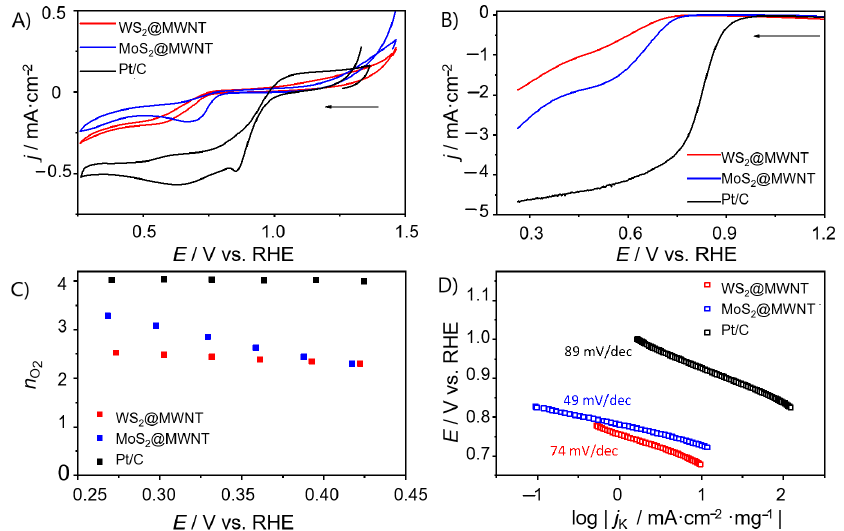
Figure 3. Electrochemical studies on WS2@MWNT, MoS2@MWNT and Pt/C. ( A ) Cyclic voltammograms (CVs) (O 2 -saturated 0.1 mol · dm − 3 KOH, v = 0.005 V · s − 1 ), ( B ) Linear sweep voltammograms (LSVs) at 1600 rpm (O 2 -saturated 0.1 mol · dm − 3 KOH, v = 0.005 V · s − 1 ), ( C ) n O2 at different potentials, ( D ) Tafel